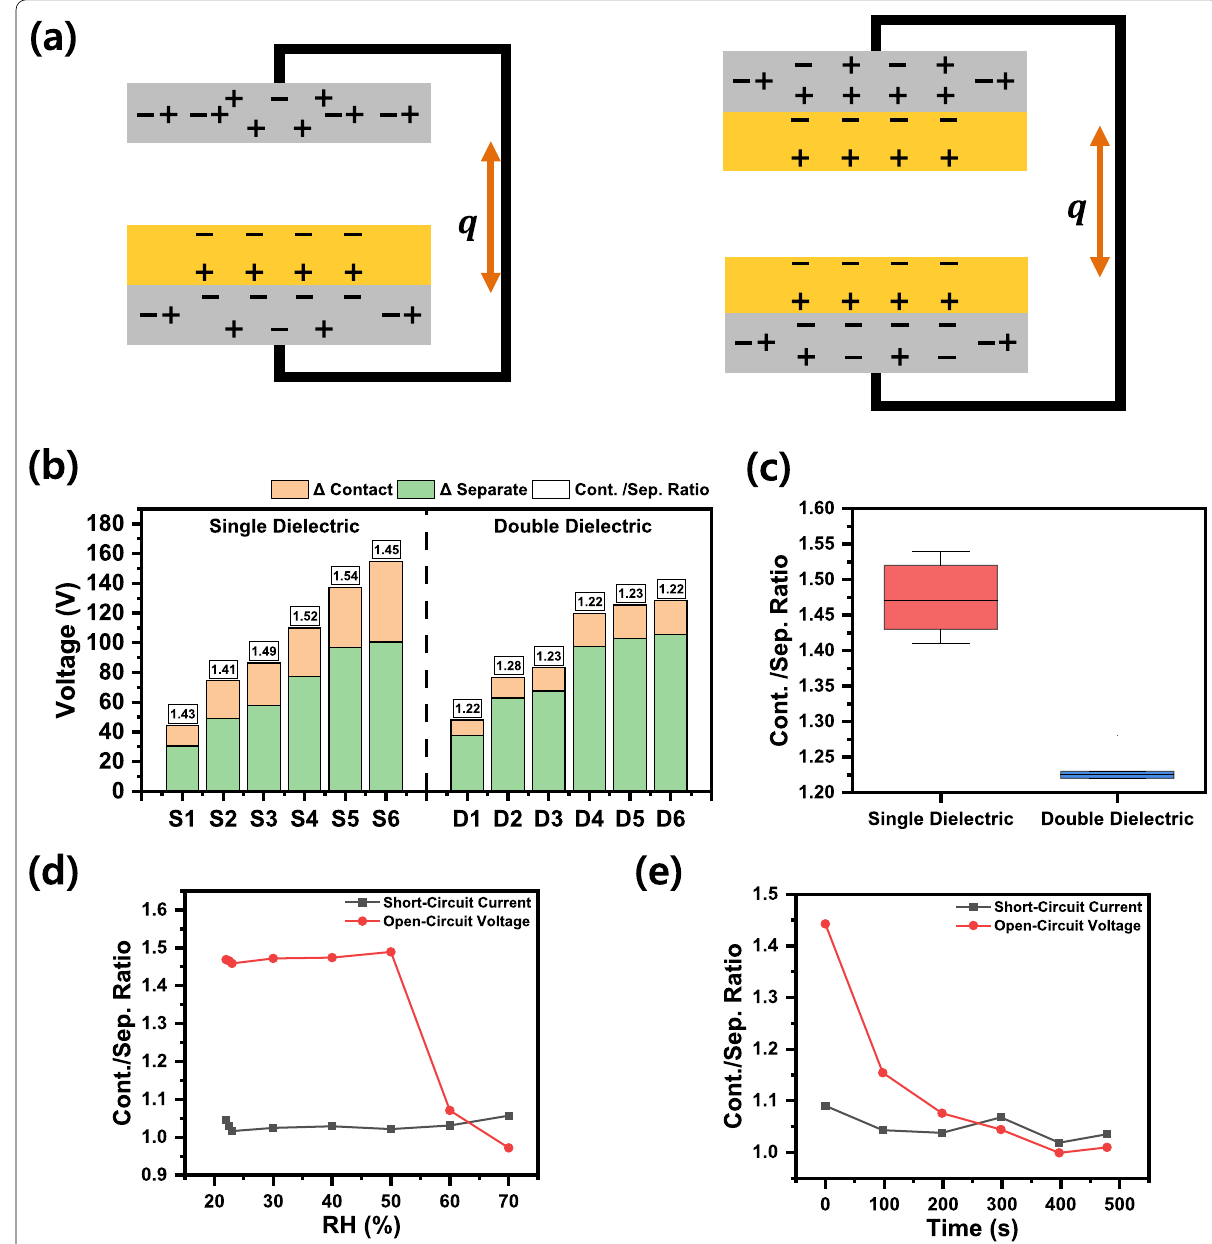
Fig. 5 a Schematic diagrams of two different charge models of single TENG and double TENG structures. b Output voltage varies according to charge balancing conditions, but the ratio between the two balancing conditions is almost the same regardless of the varying output voltage. c Summary of the ratios in b . Contact/separate ratio of open-circuit voltage and short-circuit current under d different humidity conditions and e with extended operation